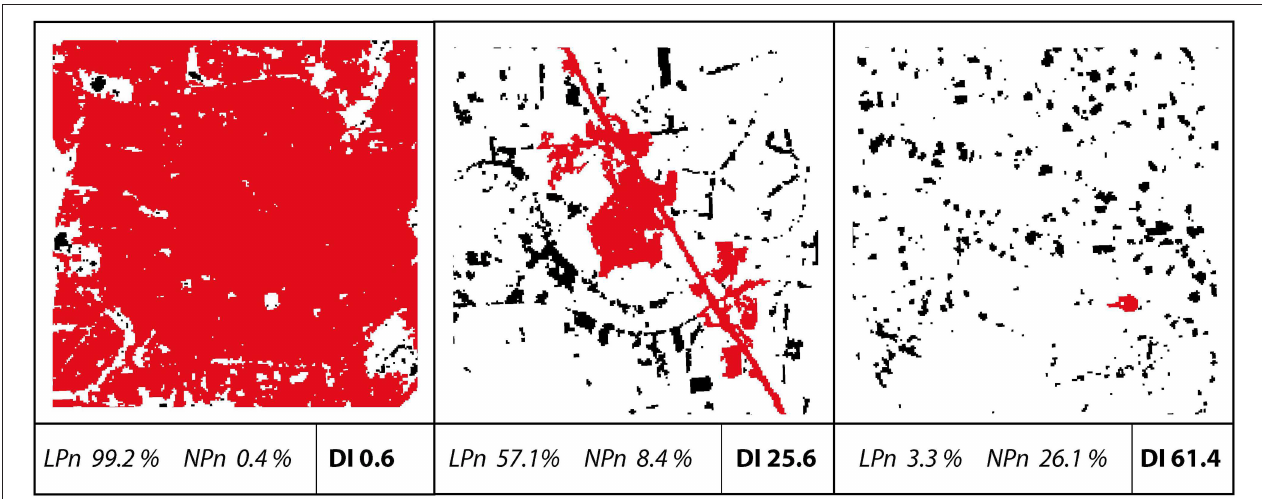
FIGURE 2 | Example for urban land use patterns and the corresponding largest patch index (LPn), normalized number of patches (NPn), and dispersion index (DI) values (urbanized land in black, largest patch in red).